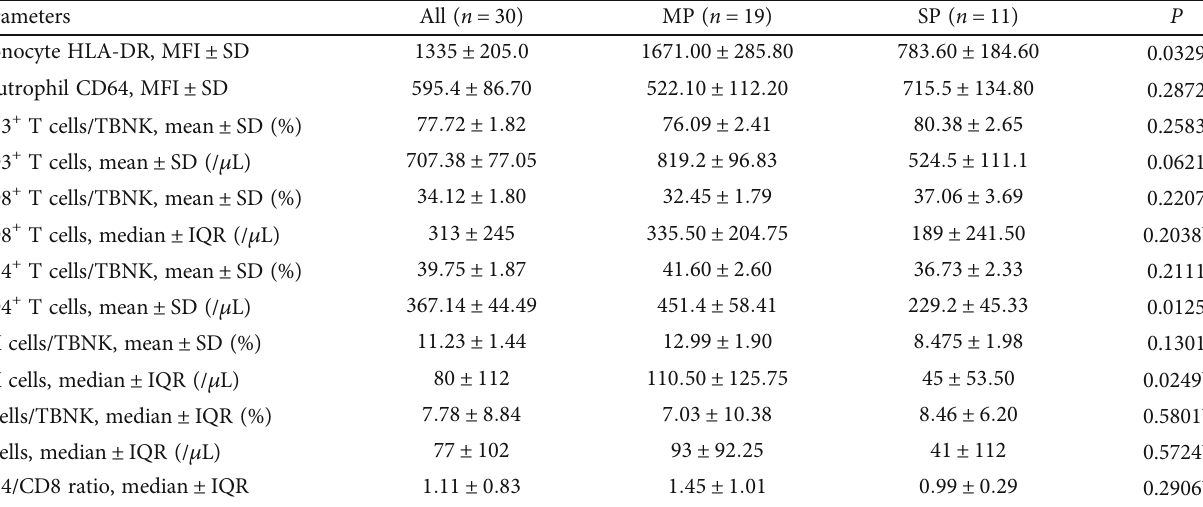
Table 3: Regular immune monitoring panel of the